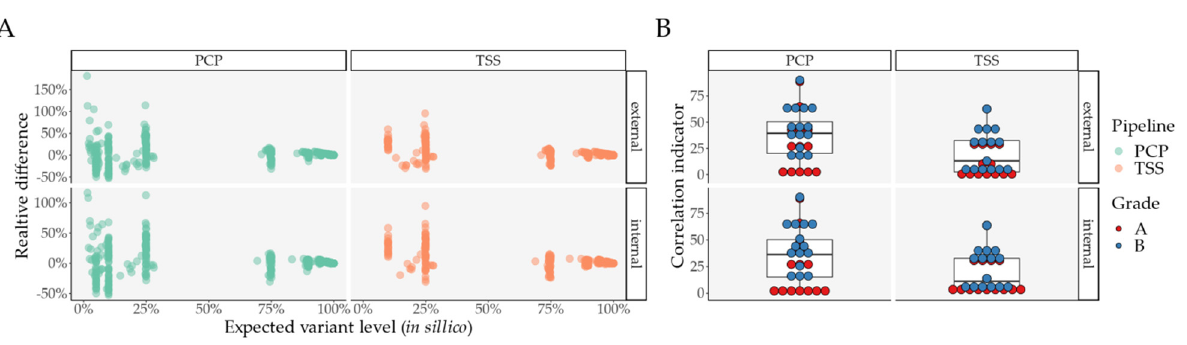
Figure 4. Mixture analysis: similarity in Grade A/B variants between expected and observed variant levels, for internal and external comparisons, per pipeline. ( A ) Relative difference between expected and observed variant level, per pipeline, and per internal and external comparison; ( B ) Correlation indicator for internal and external comparisons, per pipeline, and per variant grade. Abbreviations: PCP—PrecisionCallerPipeline; TSS—Ion Torrent Suite™